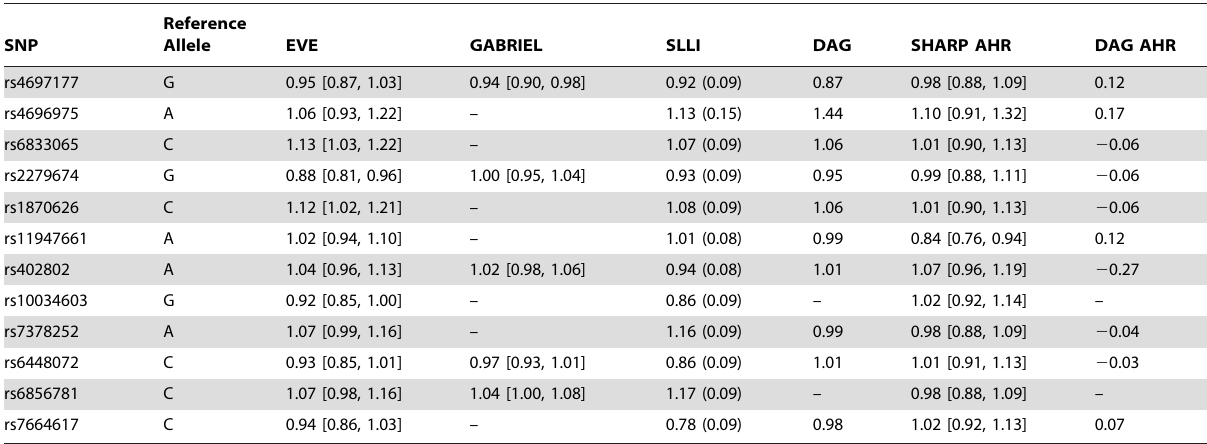
Table 3. Effect Sizes of Top KCNIP4 SNP Associations.